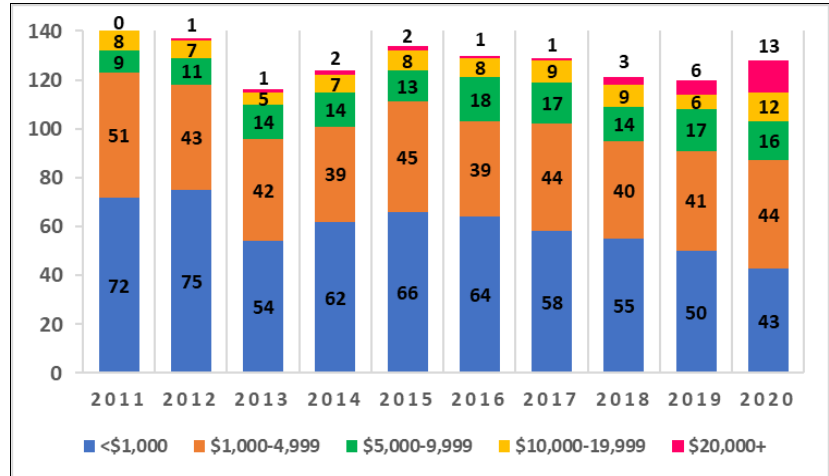
Figure 8. Percentage of Total Market Sales by Vendor Annual Sales